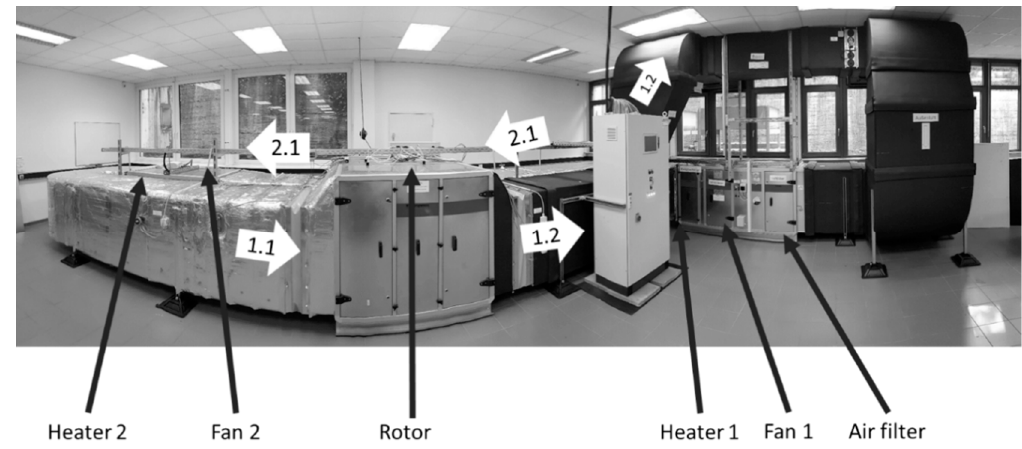
Figure 8. Pilot plant set-up panorama image.